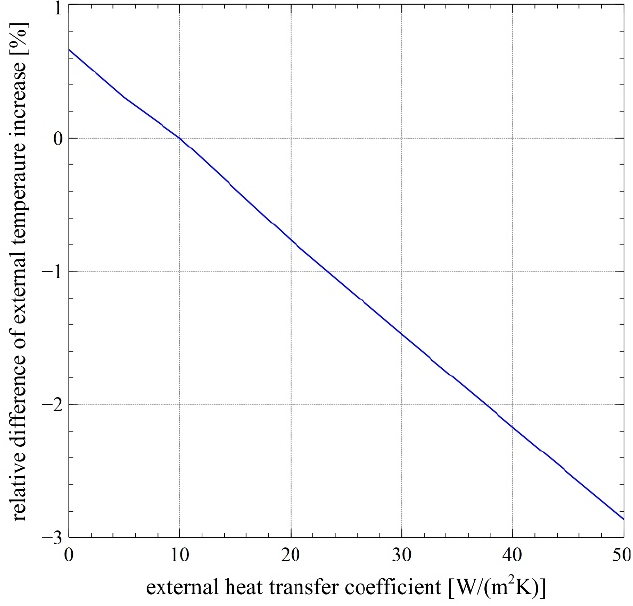
Figure 21. The influence of external surface heat transfer coefficient on the temperature increase of the external surface.